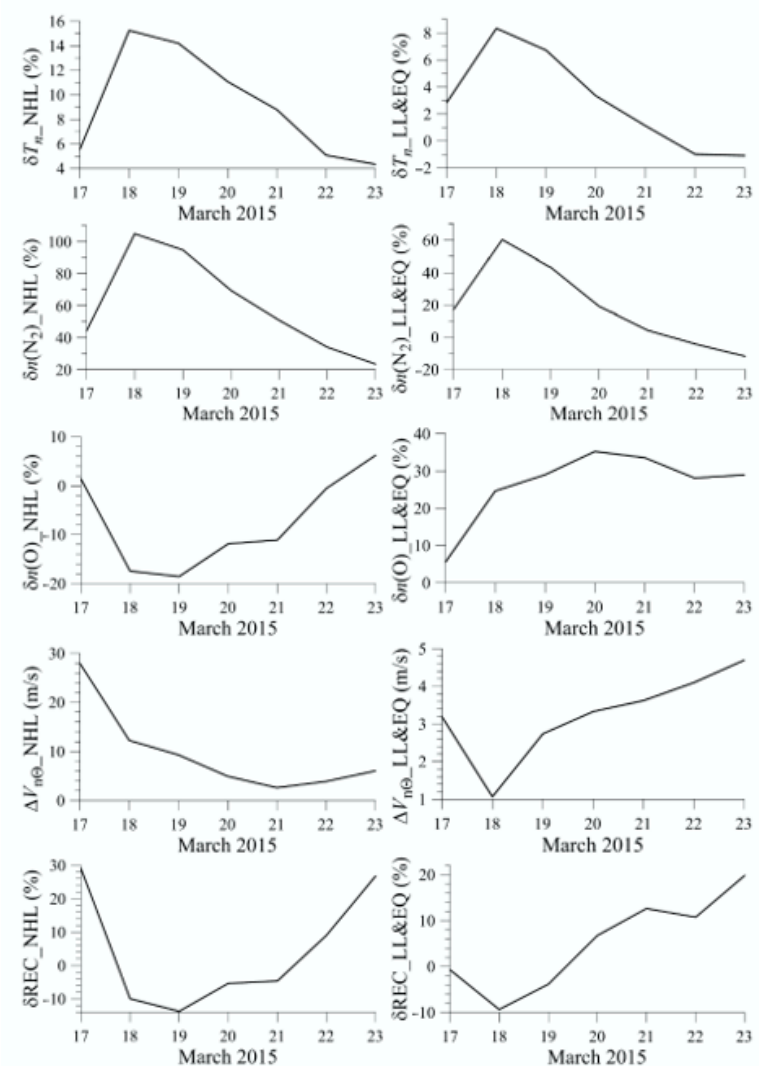
555 Figure 5. Simulated storm-induced disturbances in neutral temperature ( T n ), neutral composition ( n (O) and n (N 2 )), meridional wind velocity (V n Θ ), and REC (from top to bottom) for high ( left panel ) and low ( right panel ) latitudes on 17–22 March 2015. All characteristics are given for 250